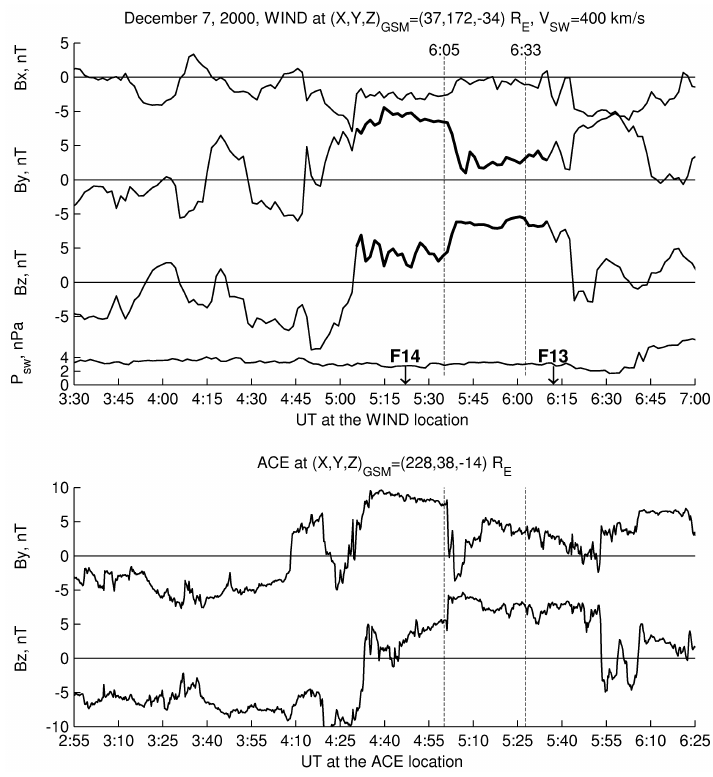
Fig. 1. Top panel: the interplanetary pa- rameters measured by the Wind satel- lite. Bottom panel: the IMF measured by the ACE satellite. The transit times of the IMF disturbance from the satel- lites to the Earth’s polar cap ionosphere were 30 and 68min for the Wind and ACE satellites, respectively. Vertical dashed lines indicate the interplanetary parameters corresponding to the Polar UVI frames in Fig. 2. Arrows indicate times of the DMSP